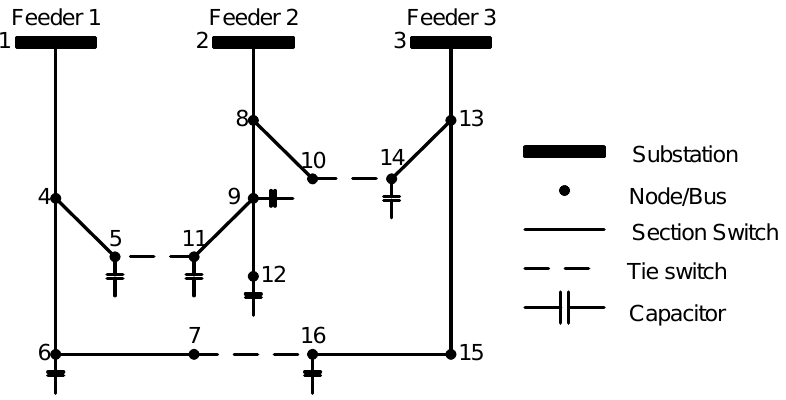
Figure 1. The IEEE 16-bus distribution system.